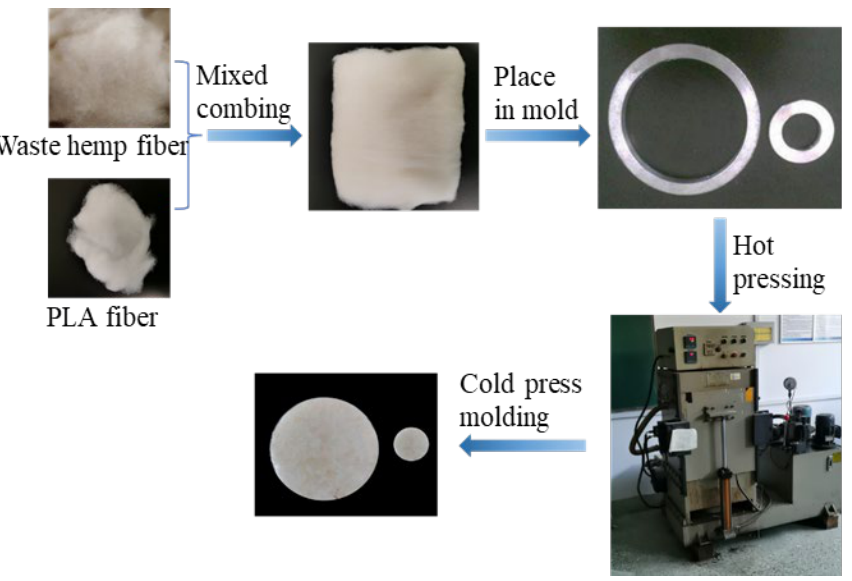
Figure 1. Preparation of waste hemp/PLA fiber composite material.